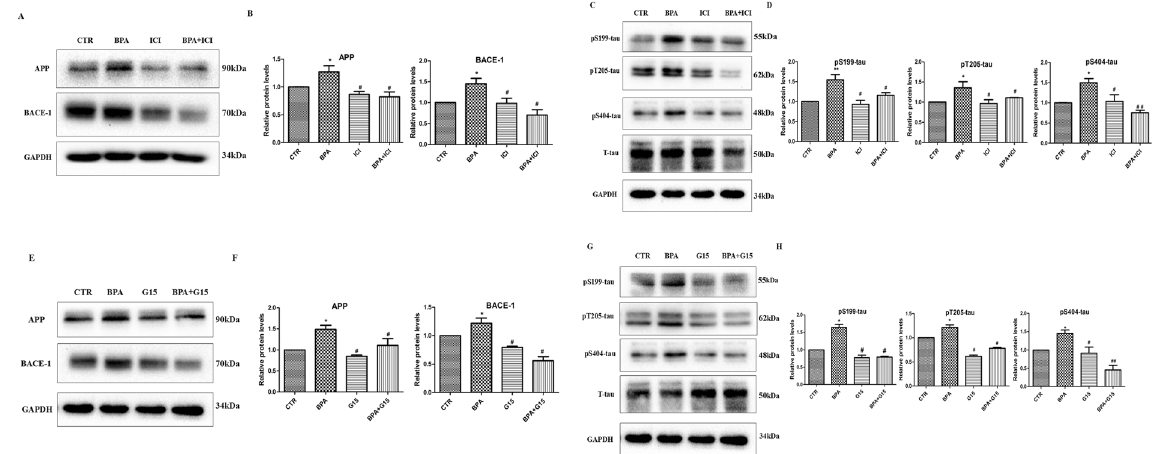
Figure 4. Estrogen receptors were involved in BPA-induced APP, BACE-1 and p-tau expressions. ( A ) ICI182780 inhibited the BPA-induced expressions of APP and BACE-1 in PC-12 cells. ( C ) ICI182780 inhibited the BPA-induced expression of p-tau in PC-12 cells. ( E ) G15 inhibited the BPA-induced expressions of APP and BACE-1 in PC-12 cells. ( G ) G15 inhibited the BPA-induced expression of p-tau in PC-12 cells. ( B , D , F , H ) GAPDH levels were assessed in parallel and served as controls. Mean values ± SEMs are representative of three independent isolations and three independent samples. Significant differences between the treatment groups and the control group were determined via one-way ANOVA and the LSD Dunnett comparison procedure. ( * P < 0.05, ** P < 0.01, *** P < 0.001 compared with the control group).